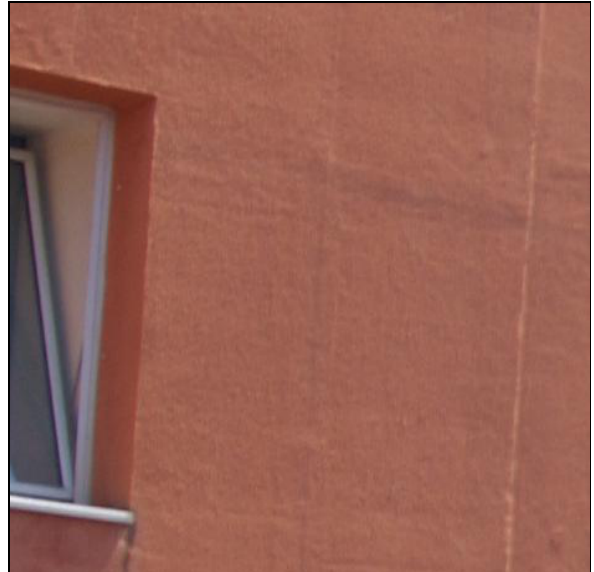
Figure 3. Histogram of images difference